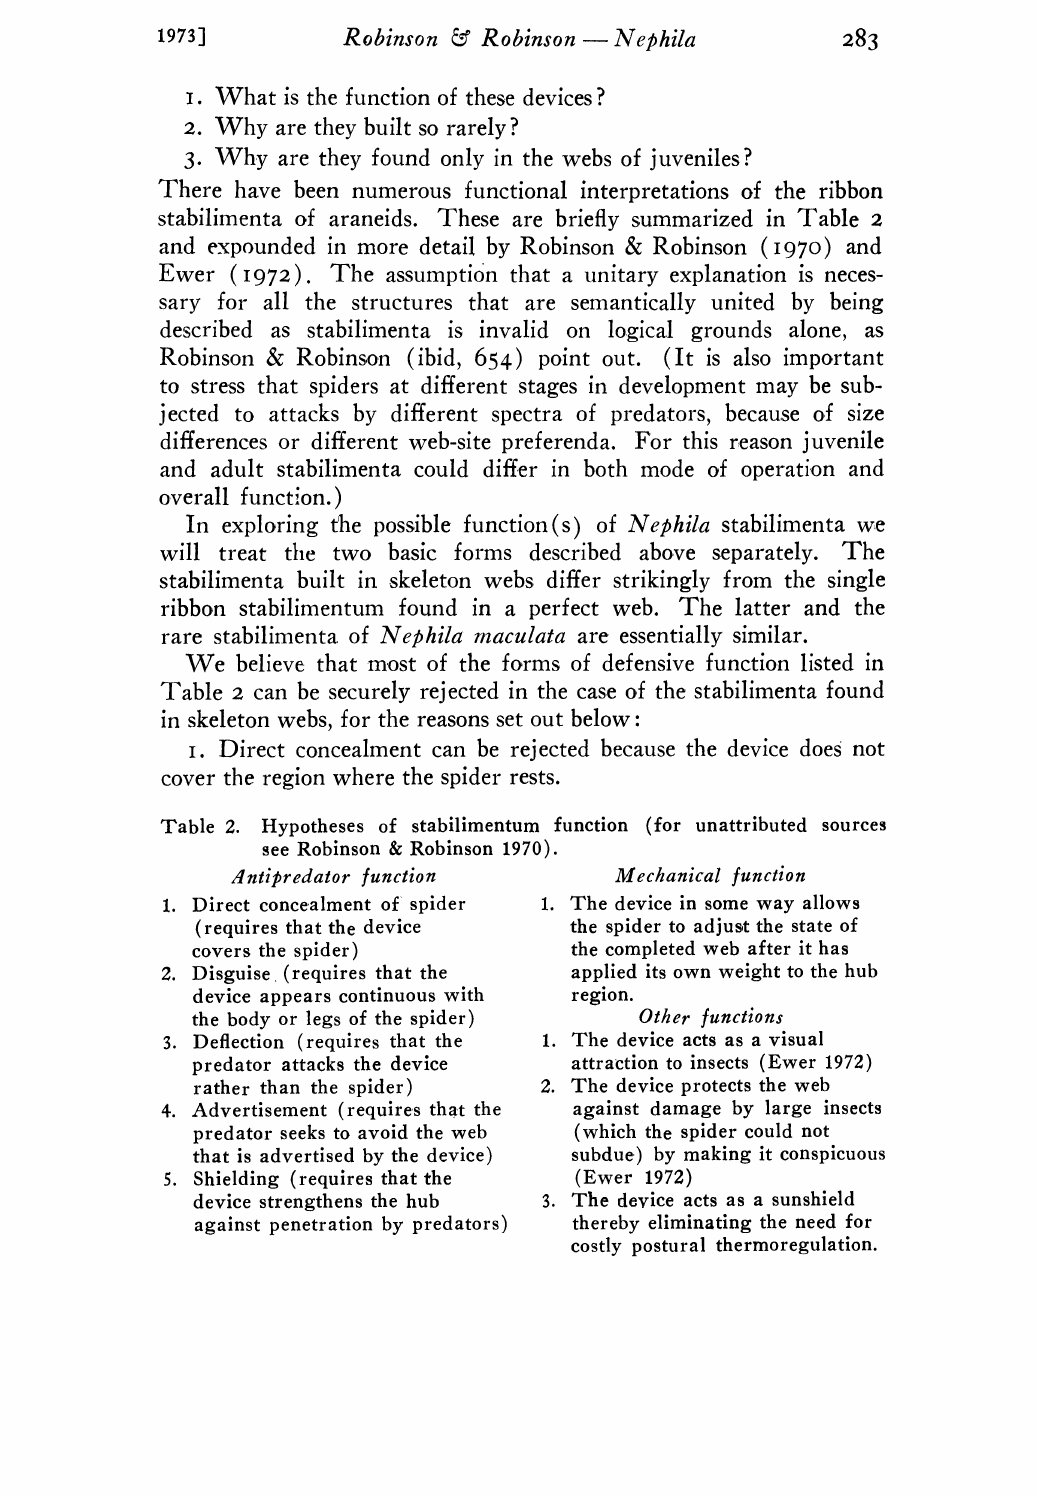
Table 2. Hypotheses of stabilimentum function (for unattributed sources see Robinson & Robinson